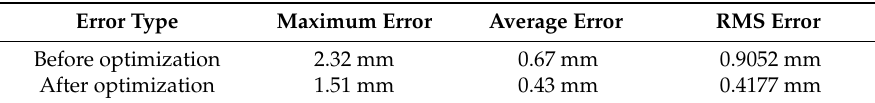
Table 3. Error from 3D points to the fitted plane.